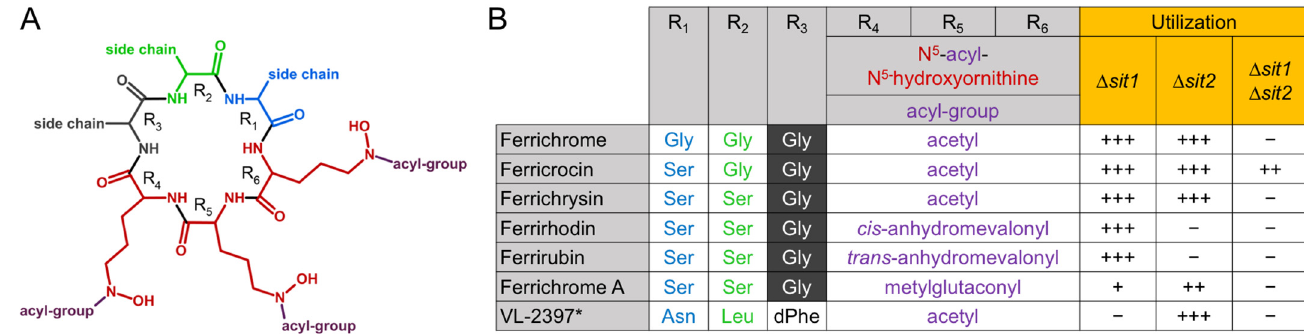
Figure 4. Comparison of the composition of different ferrichrome-type siderophores and their impact on recognition by A. fumigatus Sit1 and Sit2. ( A ) Schematic view of ferrichrome-type siderophores, which are cyclic hexapeptides with positions R 1 –R 6 . ( B ) Comparison of the ferrichrome-type siderophores used in this study with respect to composition and utilization. These ferrichrome-types differ in the N 5 -acyl groups present in positions R 4 –R 6 and the amino acid residues present in positions R 1 –R 3 , whereby glycine (shaded in black) is present in position R 3 in all these ferrichrome-types except VL-2397. Degree of utilization is marked by +++ high, ++ weak, + very weak and − no utilization. * Utilization of VL-2397 is taken from [30].